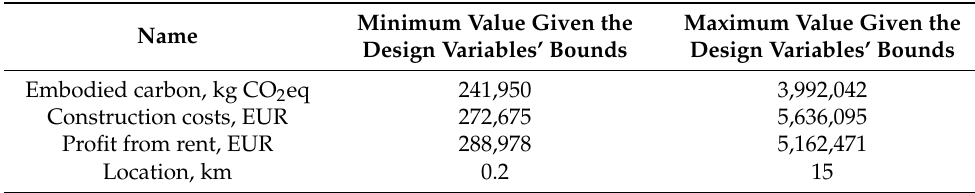
Table 4. Minima and maxima of objective functions.